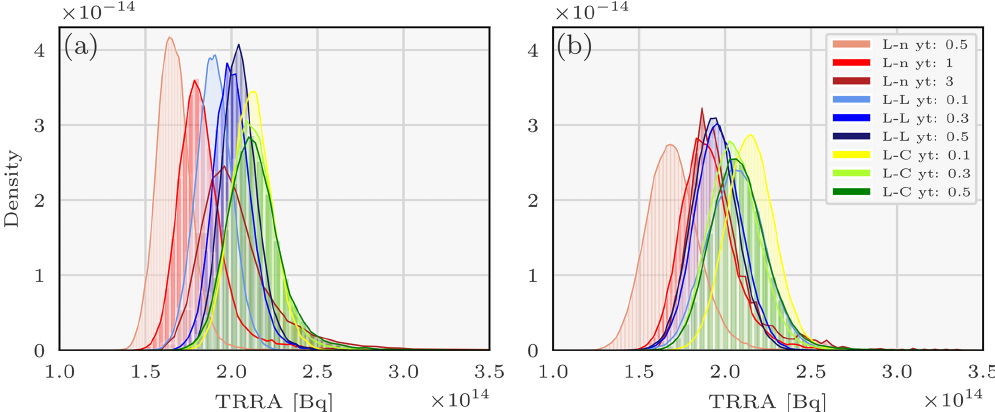
Figure 5. Pdfs of the total retrieved released activity (TRRA) describing the 106 Ru source sampled using the parallel tempering method and the observation-sorting algorithm and for various likelihoods in two scenarios: without (a) and with observation spatial clustering in nine clusters (b) . L-L means log-Laplace, L-n means log-normal, L-C means log-Cauchy, and y t is the likelihood